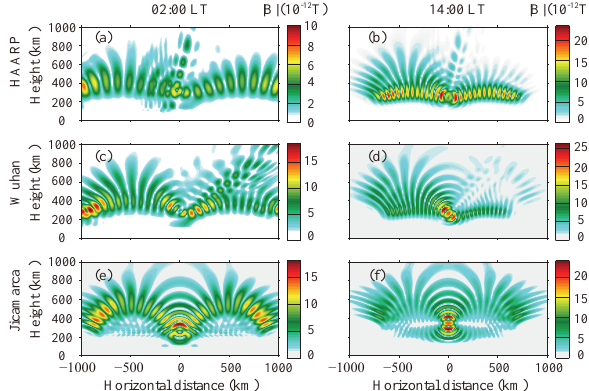
Figure 8. The Pederson conductivity profiles in the daytime and nighttime ionosphere at HAARP used in our